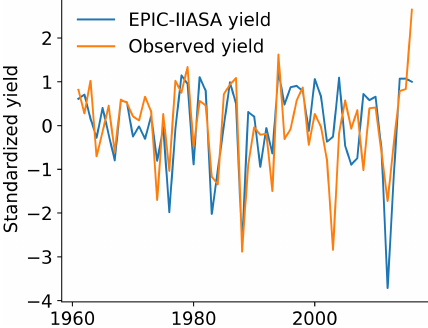
Figure C1. Standardised comparison between the EPIC-IIASA simulated yields and the observed yield dataset of the USDA (United States Department of Agriculture) for the region considered in this work.